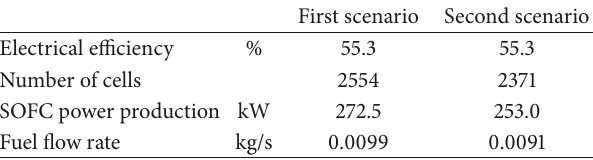
Table 6: Results of IRSOFC modeling.